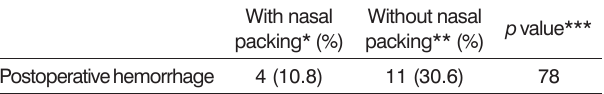
Table 2. Comparison of postoperative nasal hemorrhage in patients with and without nasal packing.